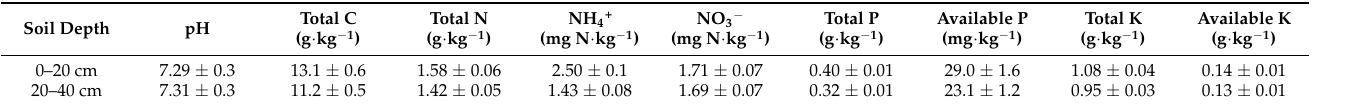
Table 1. Soil physical and chemical